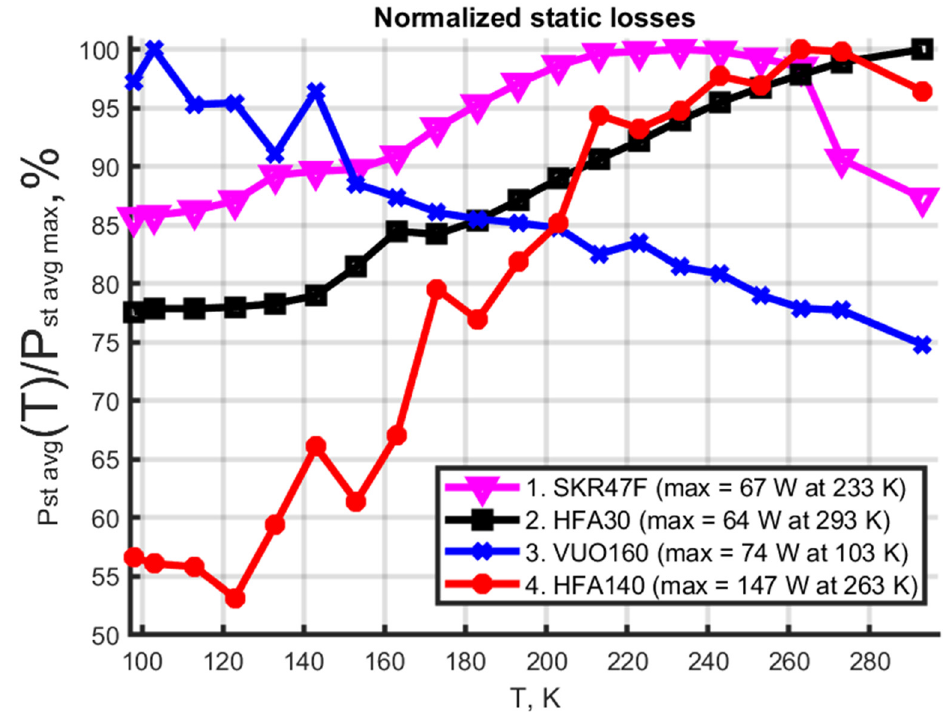
Figure 6. Normalized static losses.